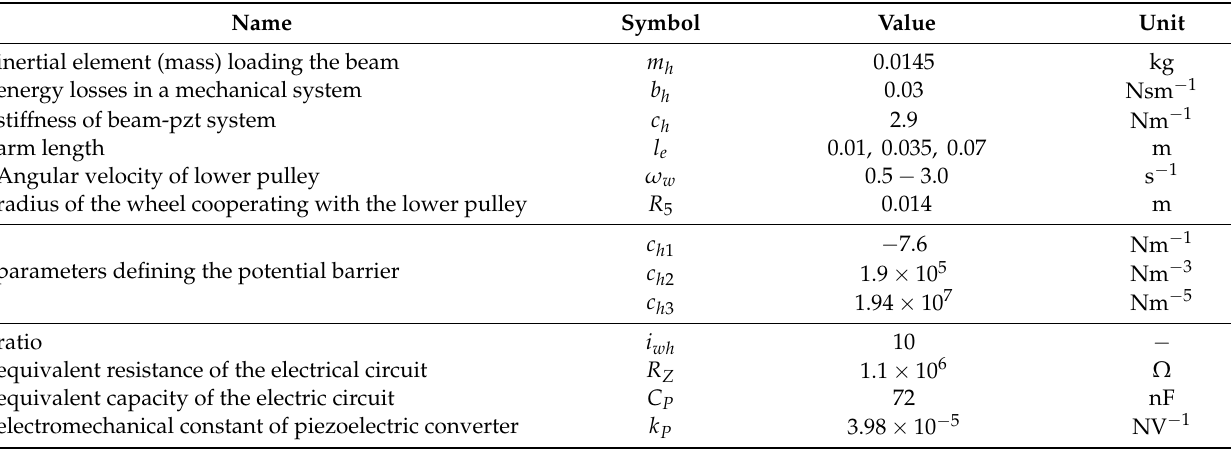
Table 5. Geometric and physical parameters of the